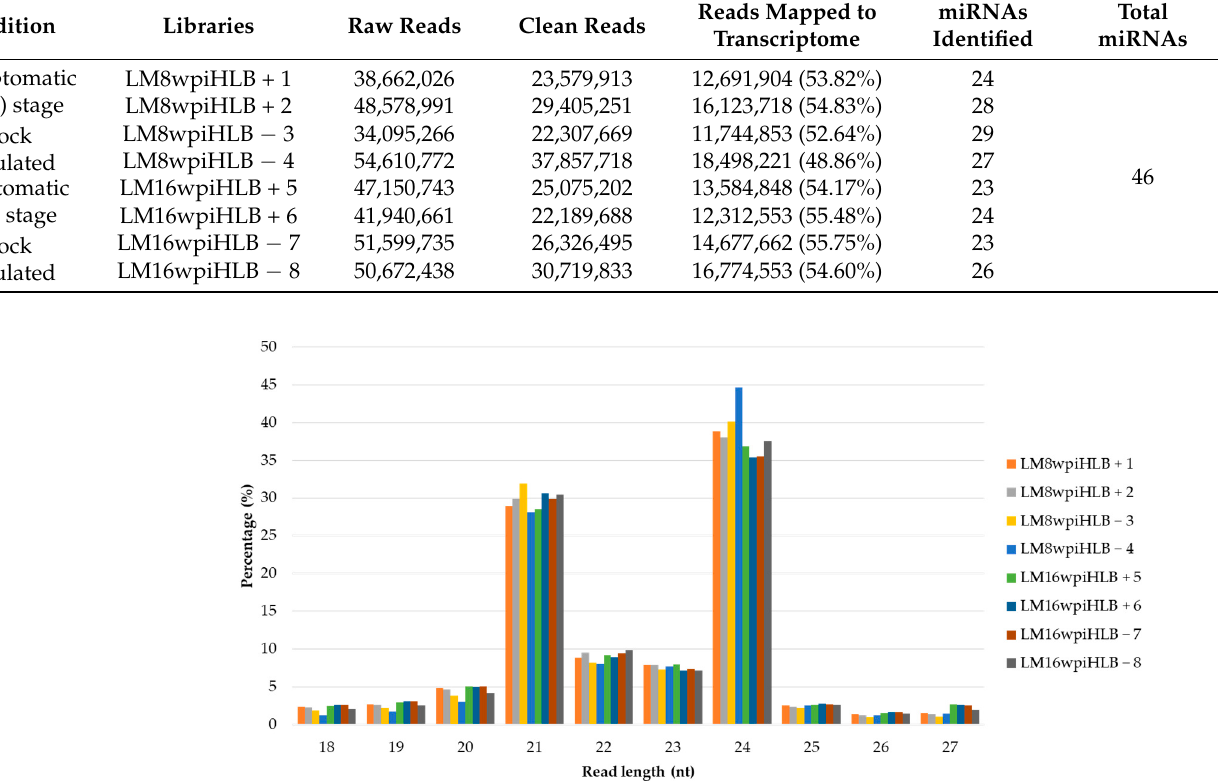
Figure 1. Small RNAs length distribution in libraries from asymptomatic and symptomatic stages of Huanglongbing (HLB) disease. HLB-infected samples (HLB + 1, 2, 5 and 6), HLB non-infected control samples (HLB − 3, 4, 7 and